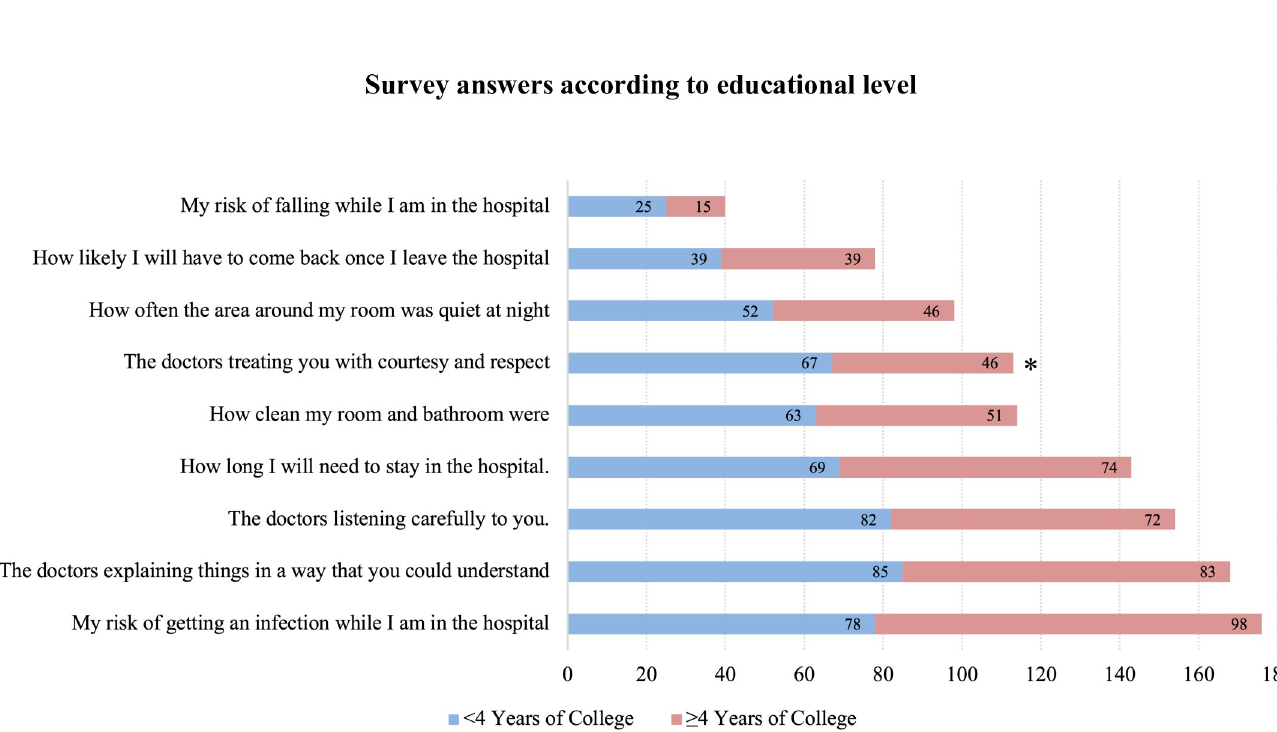
PLOS ONE | https://doi.org/10.1371/journal.pone.0258618 October 14, 2021 6 /